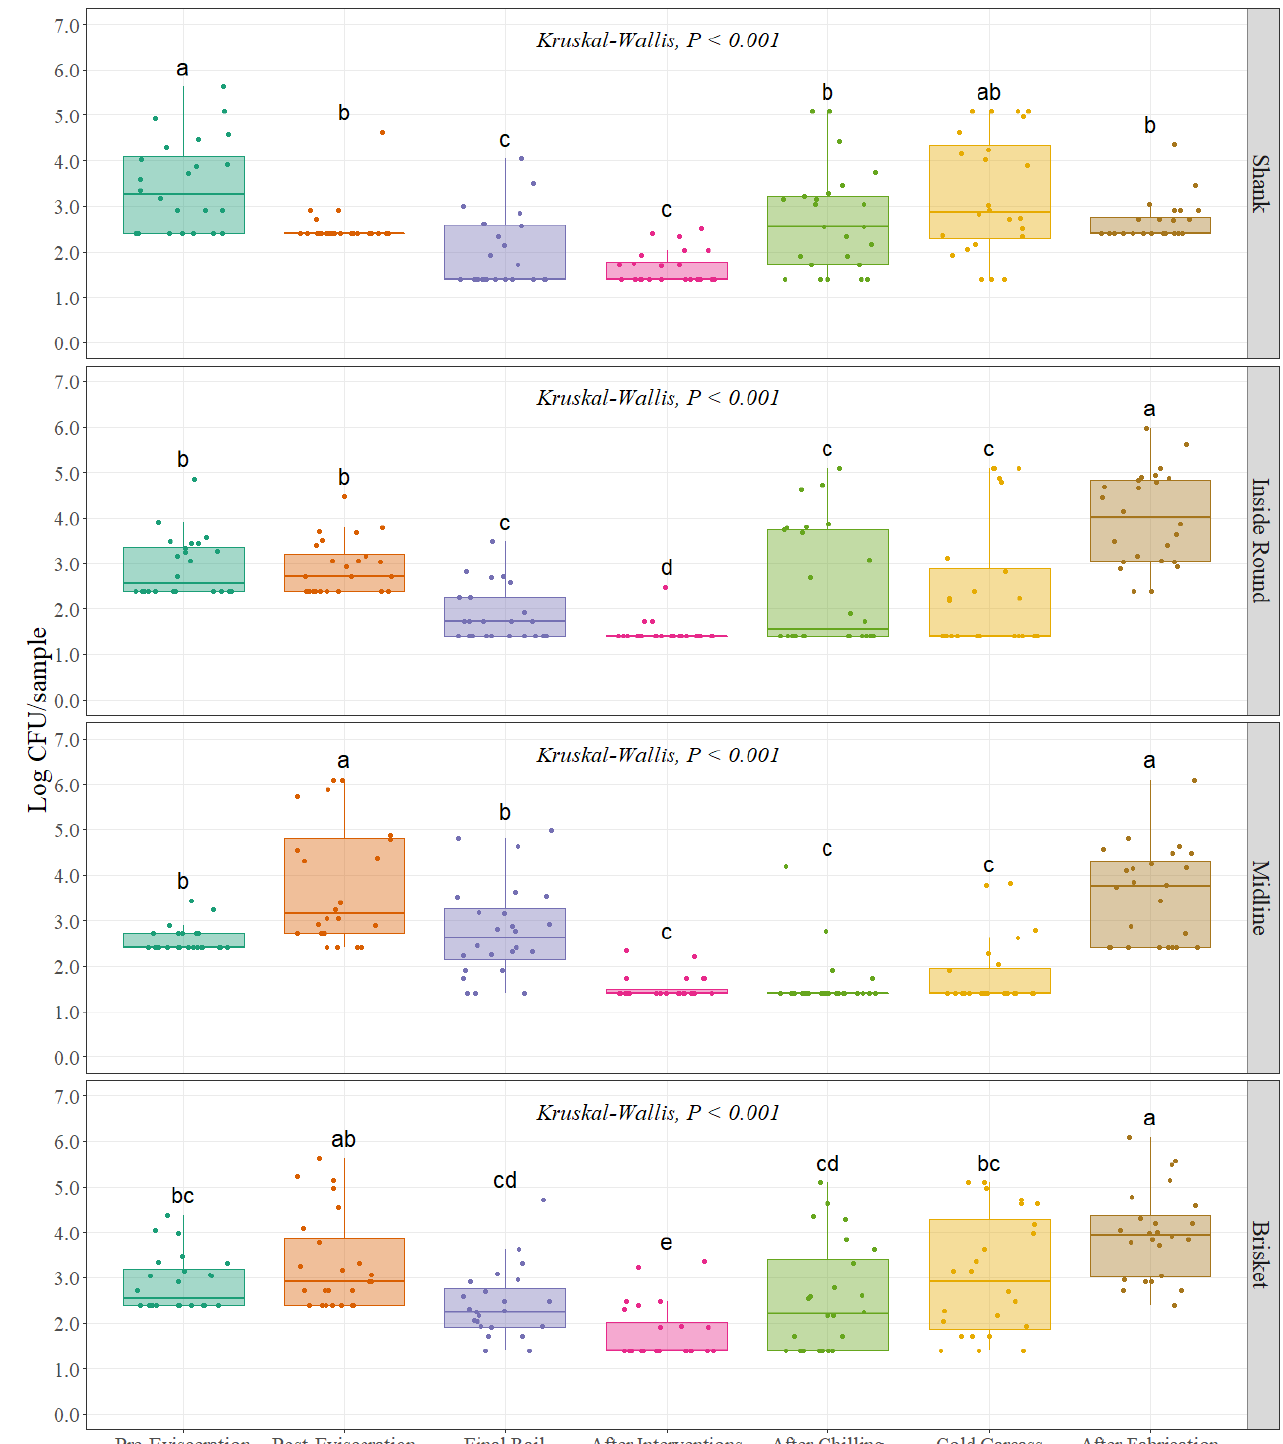
Figure 2. Enterobacteriaceae counts (Log CFU/sample; equivalent to Log CFU/100 cm 2 ) at different carcass regions throughout different sampling locations of the beef processing line (n = 24 swabs per carcass region /sampling location). In each boxplot, the horizontal line crossing the box represents the median, the bottom and top of the box are the lower and upper quartiles, the vertical top line represents 1.5 times the interquartile range, and the vertical bottom line represents 1.5 times the lower interquartile range. (a – d) For each individual carcass region, boxes with different letters are significantly different according to Kruskal – Wallis analysis followed by a pairwise comparison Wilcoxon’s test at p < 0.05. The points represent the actual data points.